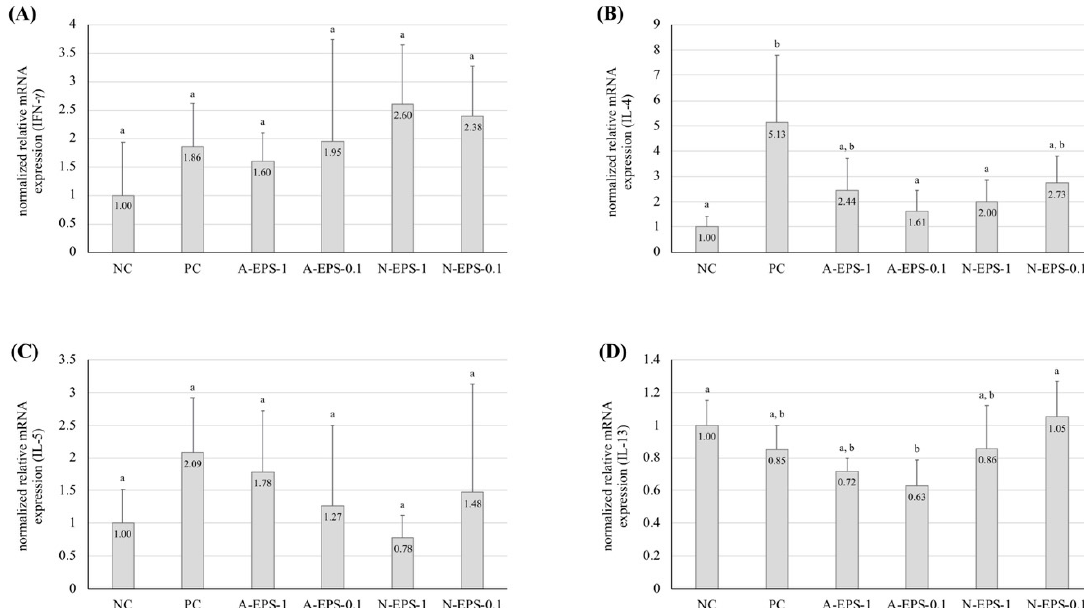
Figure 2. E ff ects of oral administration of IJH-SONE68-derived neutral and acidic EPSs on the mRNA level of IFN- γ ( A ), IL-4 ( B ), IL-5 ( C ), and IL-13 ( D ) expressed in the ear homogenates at 24 h after the challenge. Each expression level was normalized to that of the β -actin gene as a reference. Abbreviations used in the figure: NC, negative control (without inflammation); PC, positive control (without treatment); A-EPS-1, acidic EPS (1 mg / mL); A-EPS-0.1, acidic EPS (0.1 mg / mL); N-EPS-1, neutral EPS (1 mg / mL); N-EPS-0.1, neutral EPS (0.1 mg / mL). Data are indicated by mean ± S.D. Di ff erent